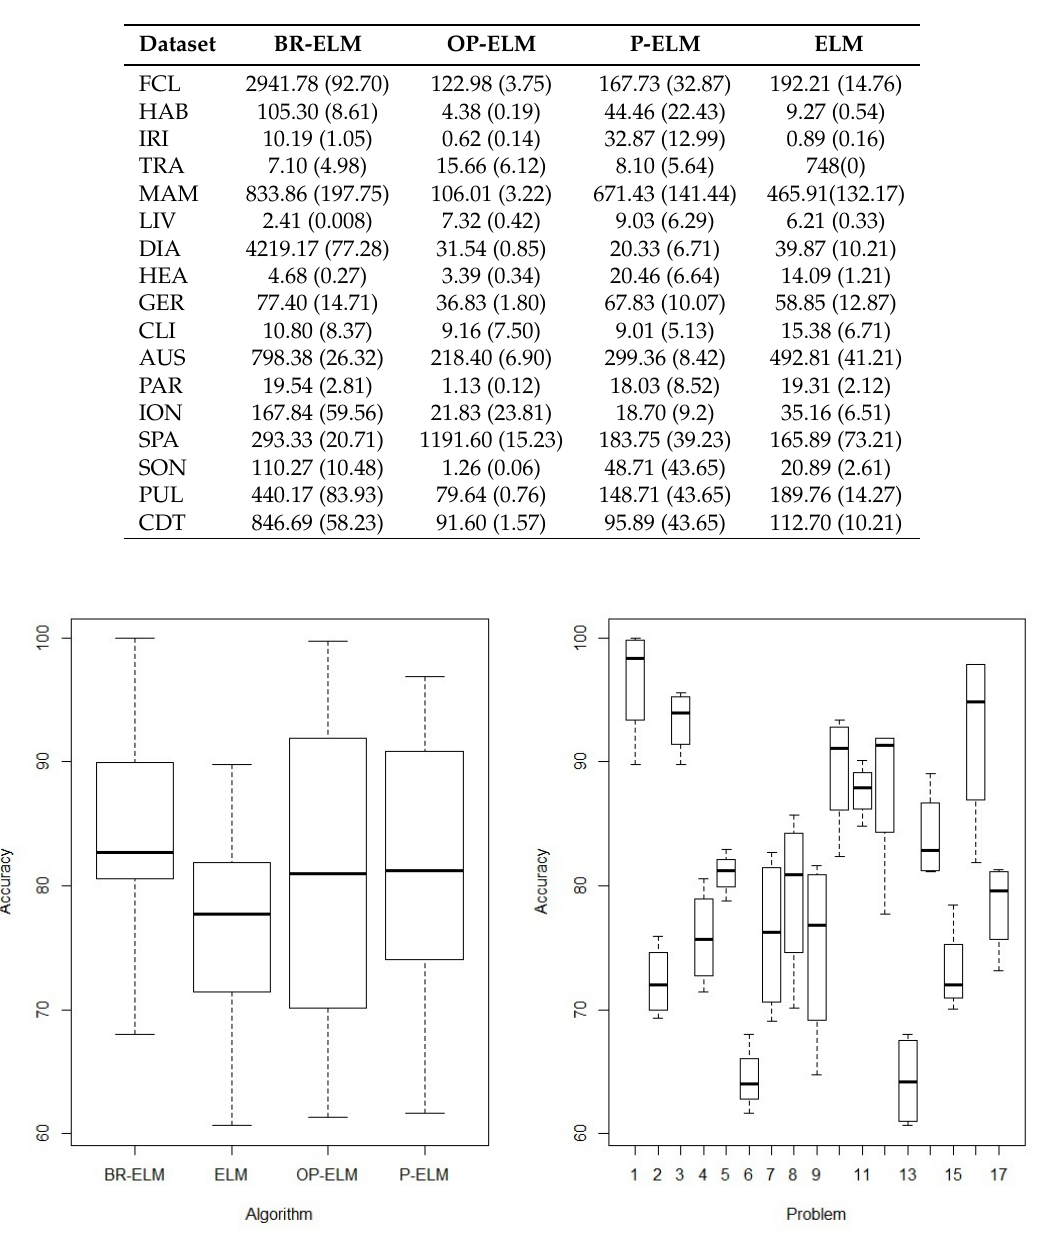
Figure 6. Plot of the average behavior of the algorithms in solving all